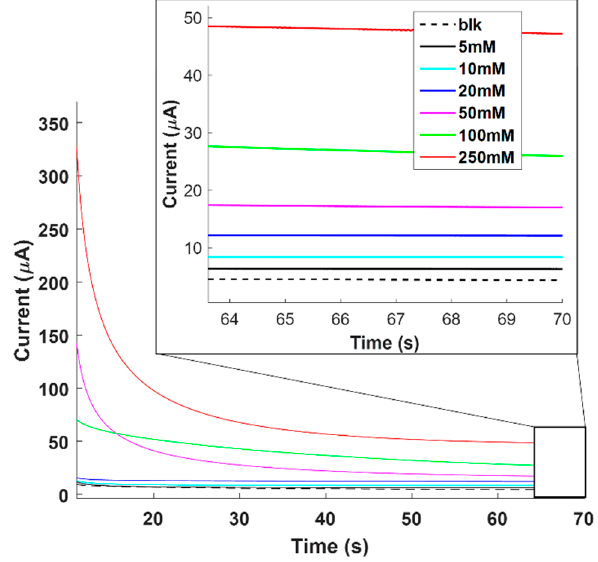
Figure 9. Calibration example based on multiple sensors for each concentration. The experimental values have been obtained for a flexible lactate biosensor. The corresponding output current is measured after the system has reached the steady state, that is after approximately 65–70 s.